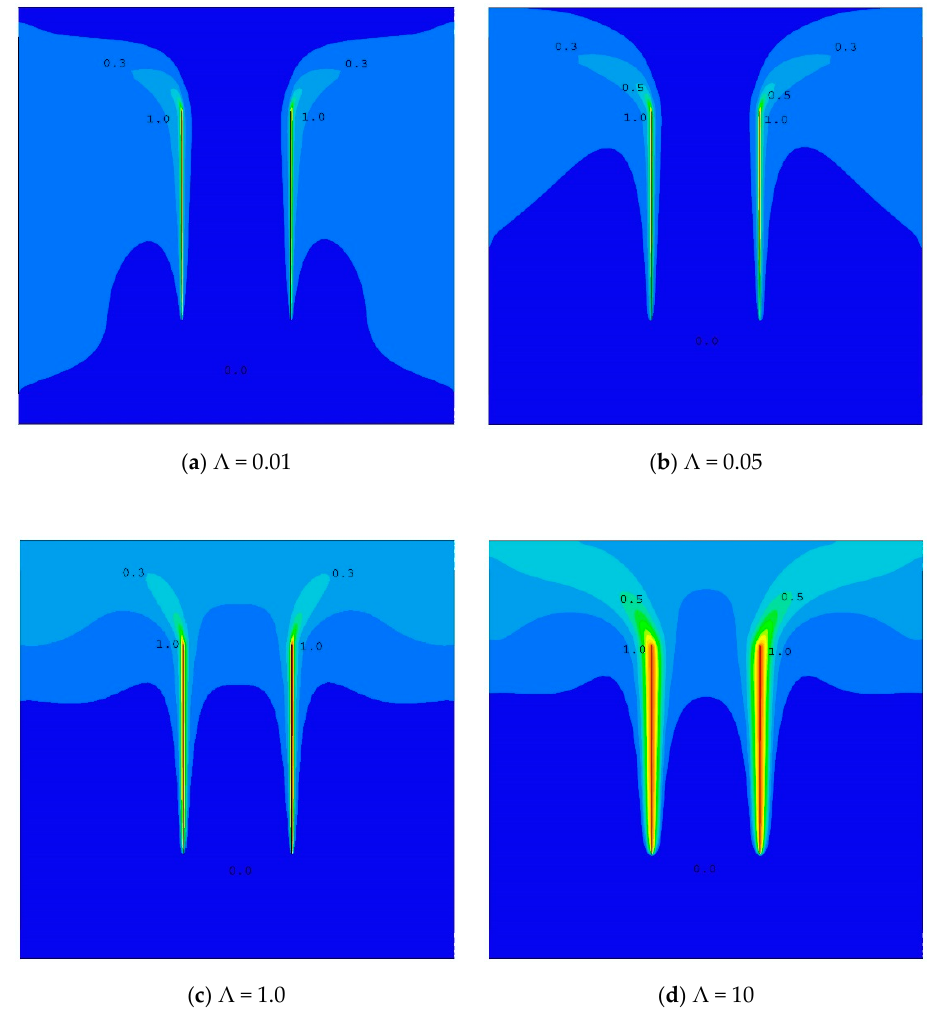
Figure 10. Filled temperature distribution for Ra H = 10 9 , b / H = 0.5, and different values of heating parameter Λ , including representative values of θ = ( T − T ∞ )/( T w − T ∞ ), from 0 (cold fluid, blue color) to 1 (heated fluid, red color). Configuration is given in Figure 1b.